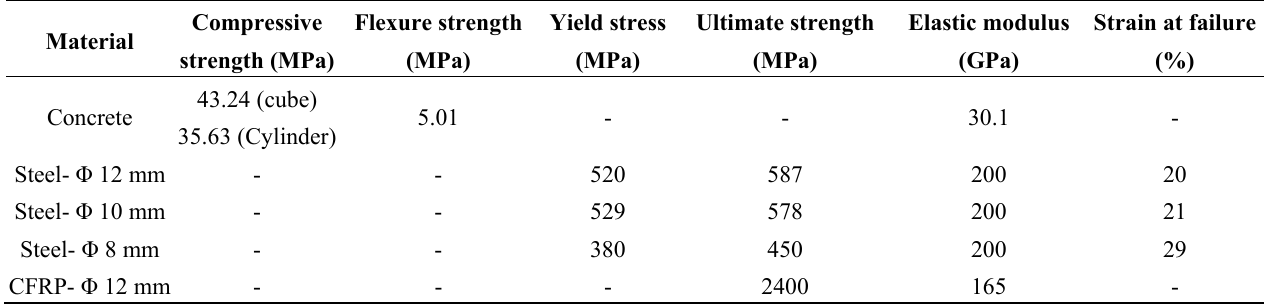
Table 2. Properties of Concrete, Internal Steel Reinforcement and CFRP Bar. Φ = diameter.